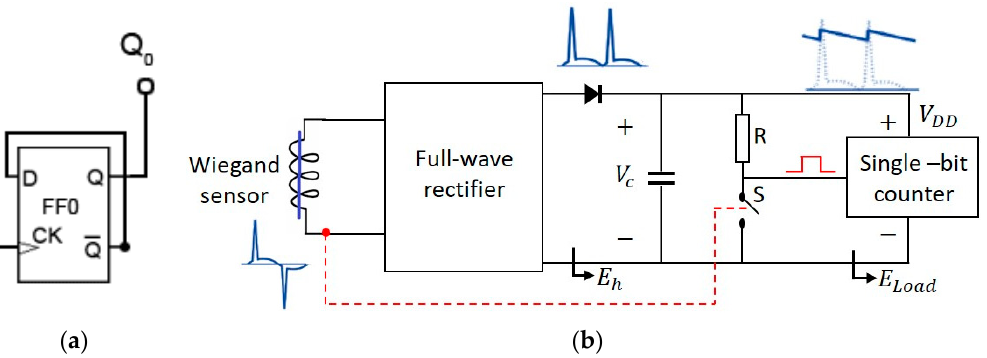
Figure 5. ( a ) Single-bit asynchronous counter using a D flip-flop. ( b ) Power supply plus clock signal generation for the asynchronous counter.